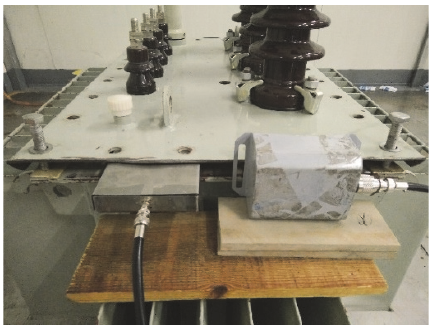
Figure 17: Placement of the antipodal Vivaldi antenna and rectangular plane spiral